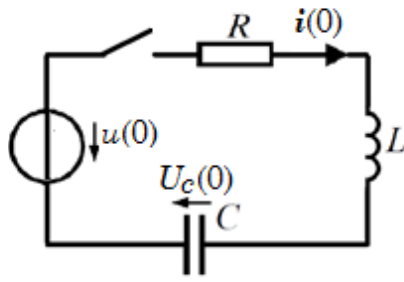
Figure 1. RLC circuit before a switching.